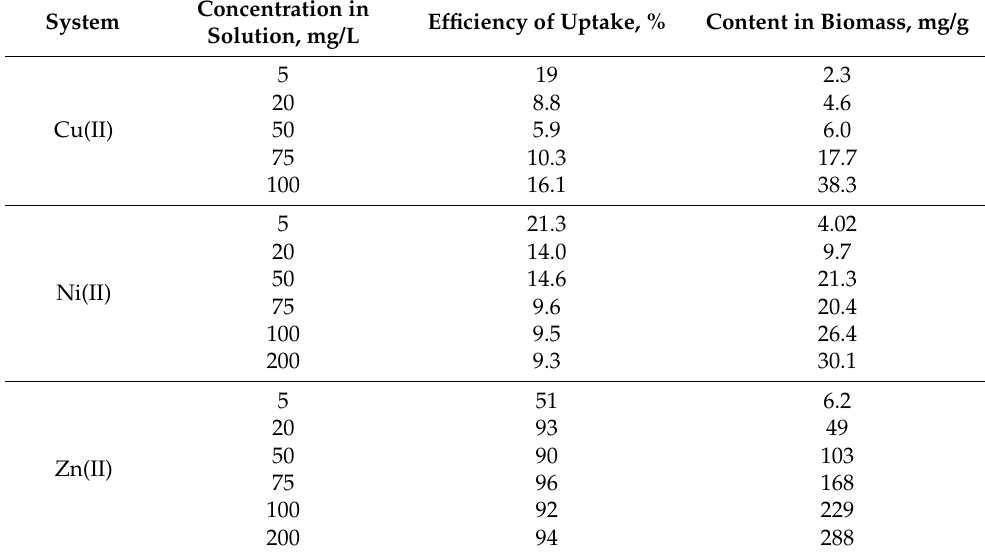
Table 1. The content of metal accumulated in biomass and the efficiency of metal uptake from single-metal